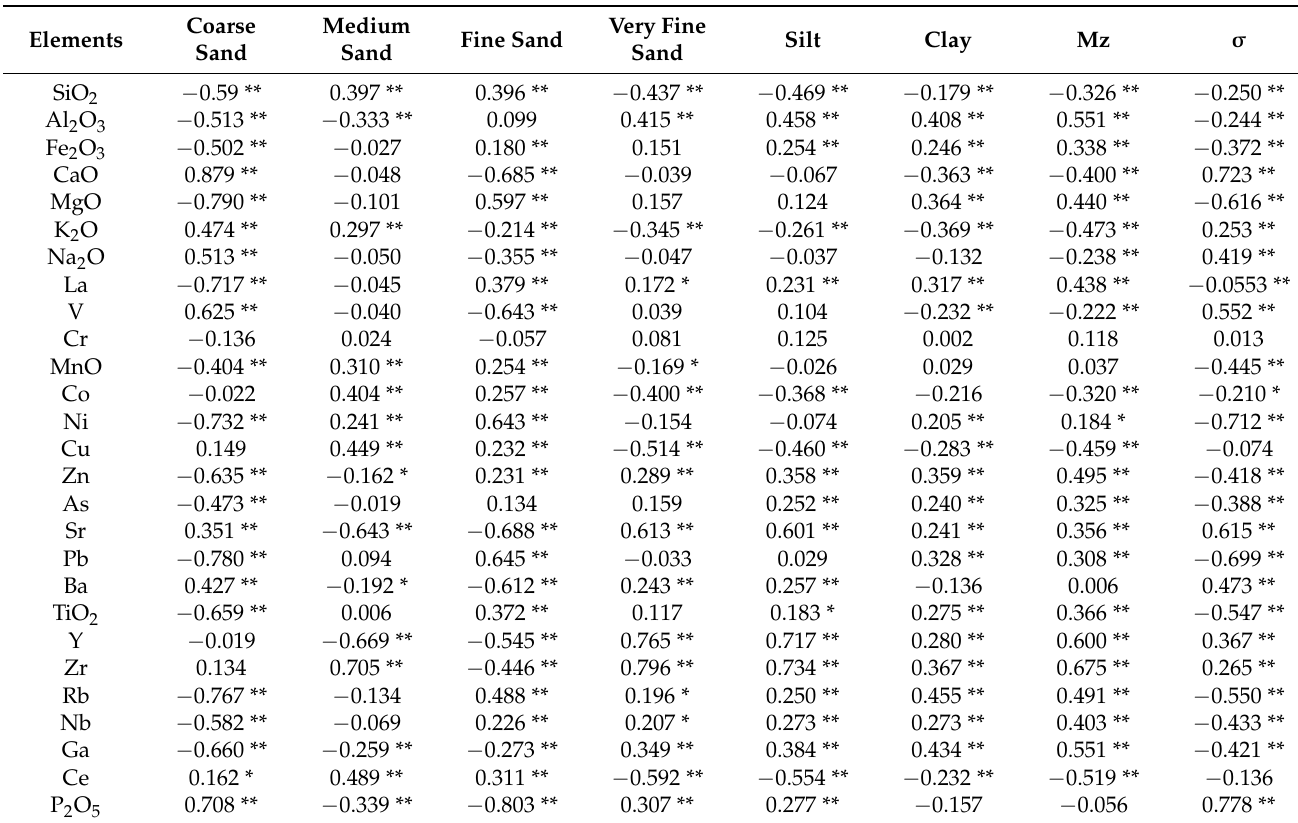
Table 5. Correlation analysis of grain size fractions and parameters with